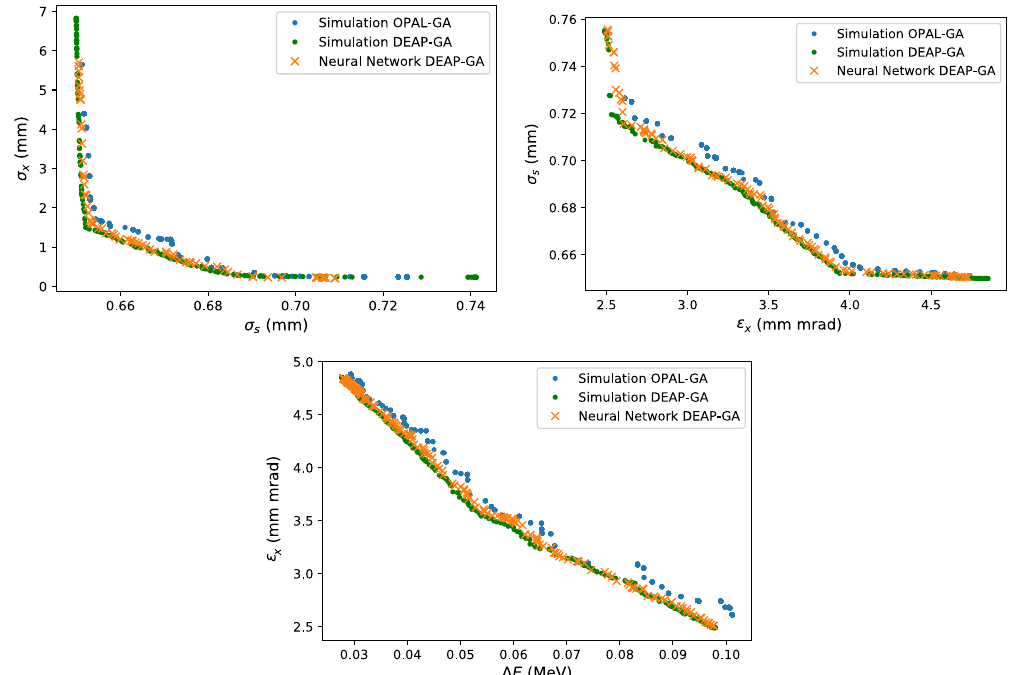
FIG. 16. ComparisonbetweenestimatedParetofrontsobtainedwiththe OPAL implementationof NSGA - II andthe DEAP implementationof NSGA - II after 200 generations, with 656 individuals in each generation. We also show the result from running DEAP on the neural network surrogate model. We consider these to be in sufficiently close agreement; please refer to the text for more